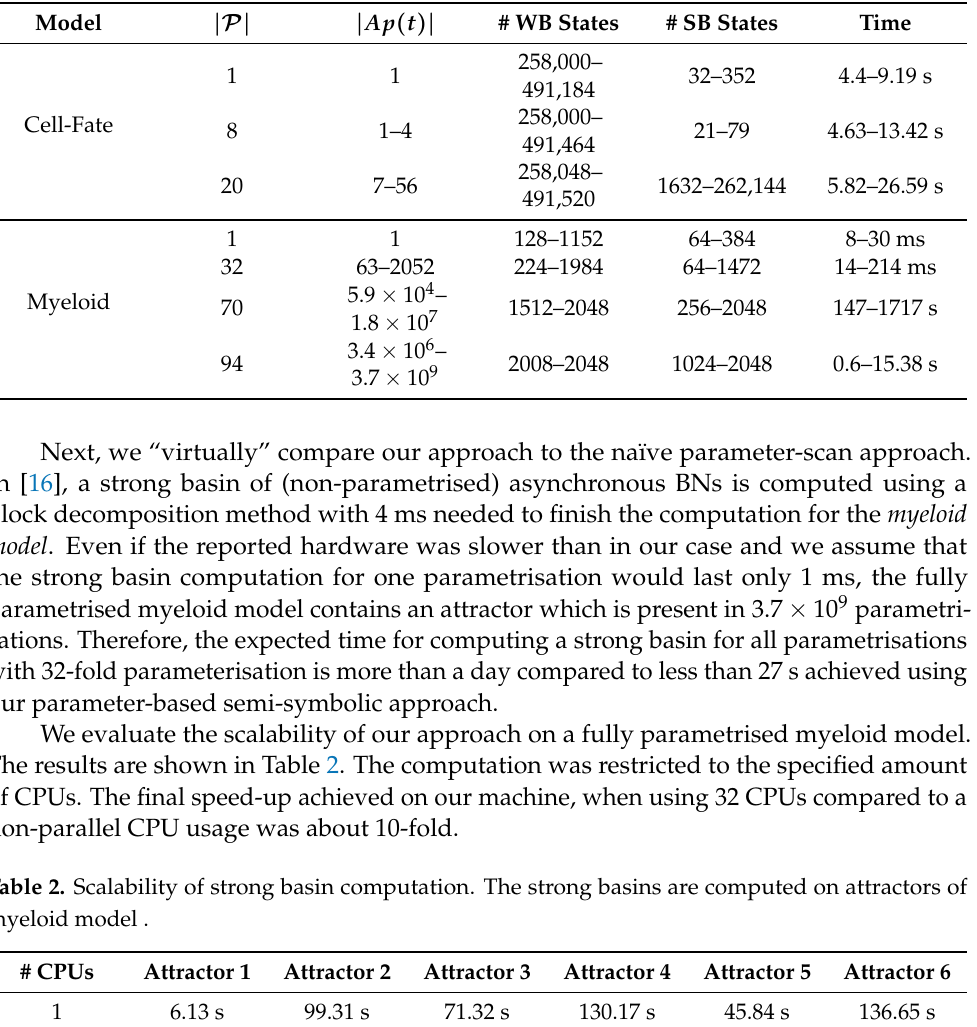
Table 1. Results of strong basins computation. The values are stated as ranges because we computed strong basins of all attractors considered in the given models. The second column shows the number of model’s parameters. The third column shows count ranges of parametrisations which contain the given attractor. The fourth and fifth columns display ranges of the number of states in the weak (resp. strong) basins. The last column contains ranges of times needed to compute strong basins.